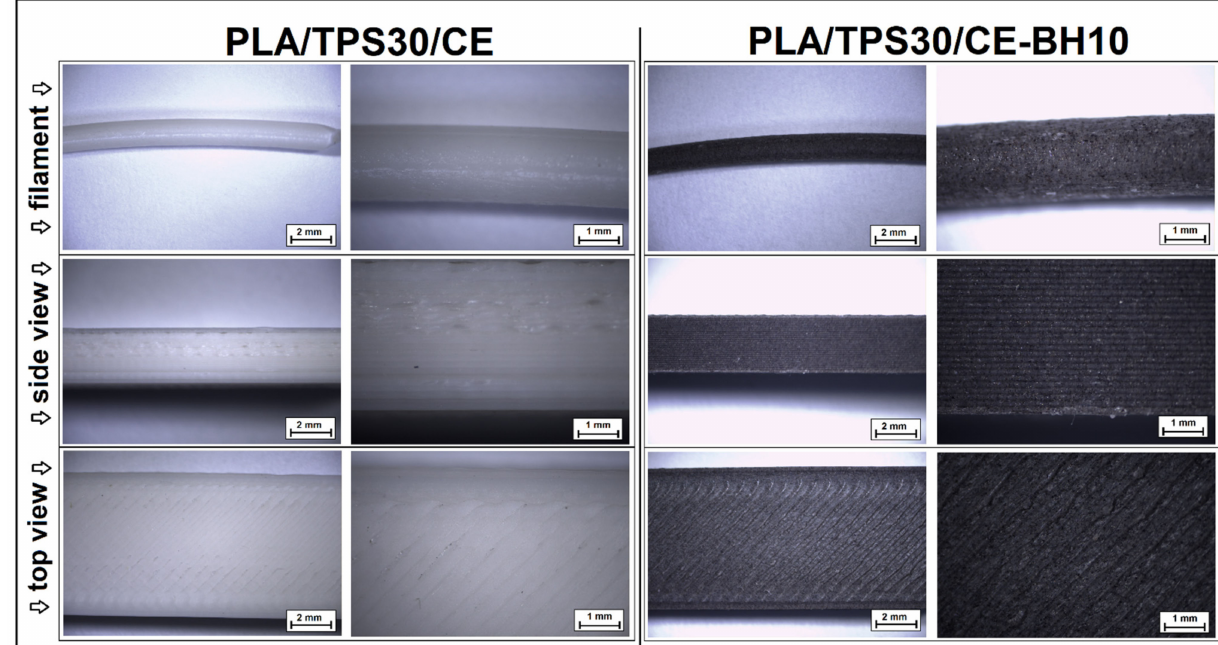
Figure 5. The appearance of the prepared unfilled PLA/TPS30/CE and PLA/TPS30/CE-BH10 samples. Pictures present the filament material, and side and top view of the printed